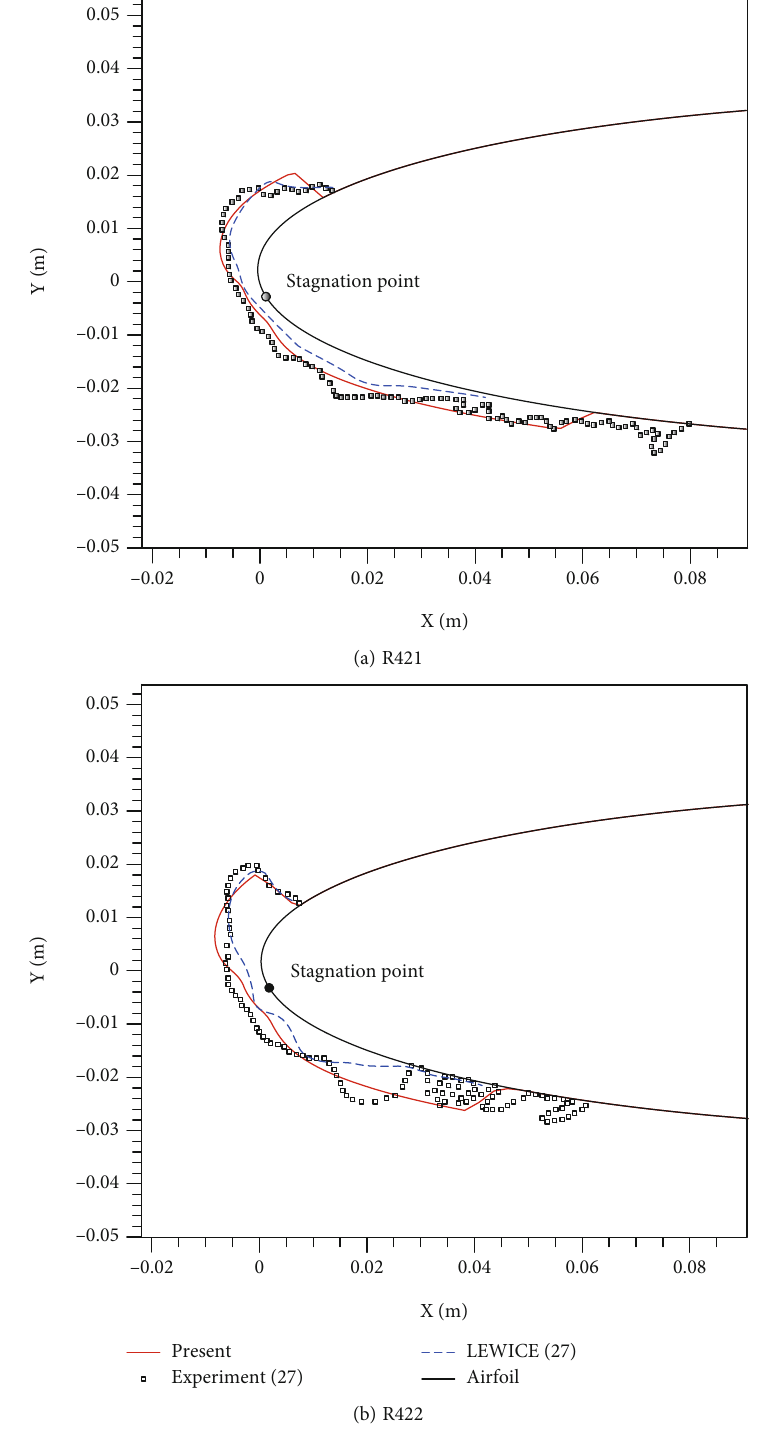
Figure 4: Comparisons of the ice shapes with the literature data for glaze